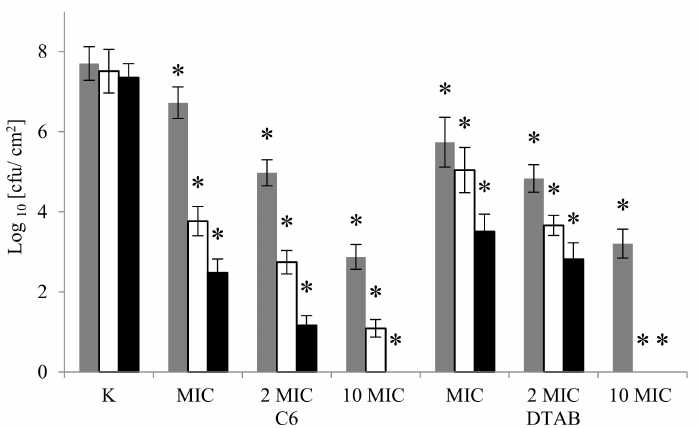
Figure 4. Effect of gemini C6 ( a ) and monomeric DTAB ( b ) surfactants on eradication of biofilm formed by A. lannensis FMW1. The results are presented after 1 h (dark grey bar), 4 h (white bar) and 24 h (black bar) treatment by surfactants in the concentration MIC, 2 MIC and 10 MIC, and compared to the control sample (K) without surfactants. * Reduced value of log 10 differed significantly from the control without surfactant